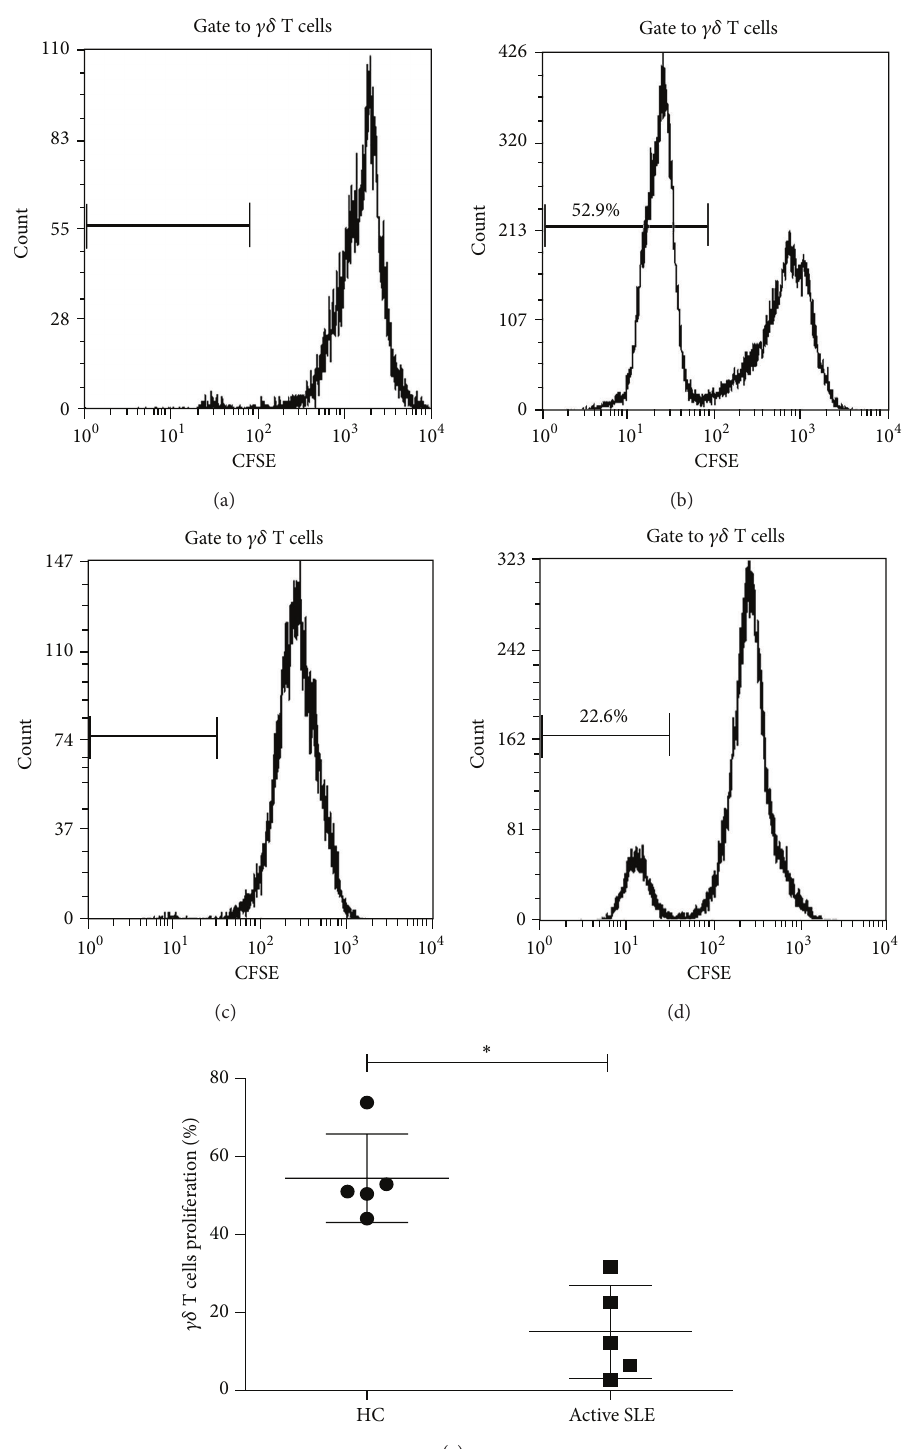
Figure 4: Reduced 𝛾𝛿 T cell proliferation in active SLE patients. (a) and (b) Proliferation of 𝛾𝛿 T cells in one healthy control cultured without or with stimulation of rhIL-2 (200U/mL) and immobilized anti-human 𝛾𝛿 TCR (1ug/mL) for 7 days. (c) and (d) Proliferation of 𝛾𝛿 T cells in a SLE patient cultured without or with stimulation. (e) Comparison of 𝛾𝛿 T cell proliferation under the stimulation of rhIL-2 and immobilized anti-human 𝛾𝛿 TCR between active SLE patients and healthy controls ( 𝑛 = 5 , ∗ 𝑃 < 0.01